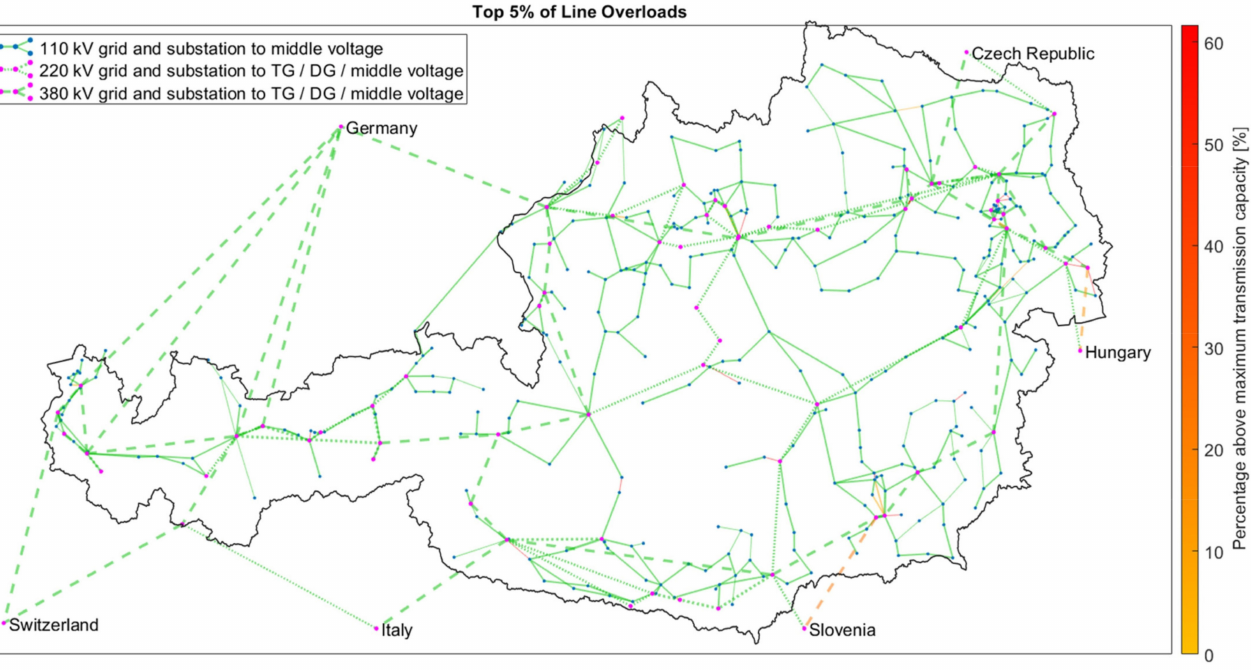
Figure 19. The top 5% line overloads of Austria’s power grid—Scenario